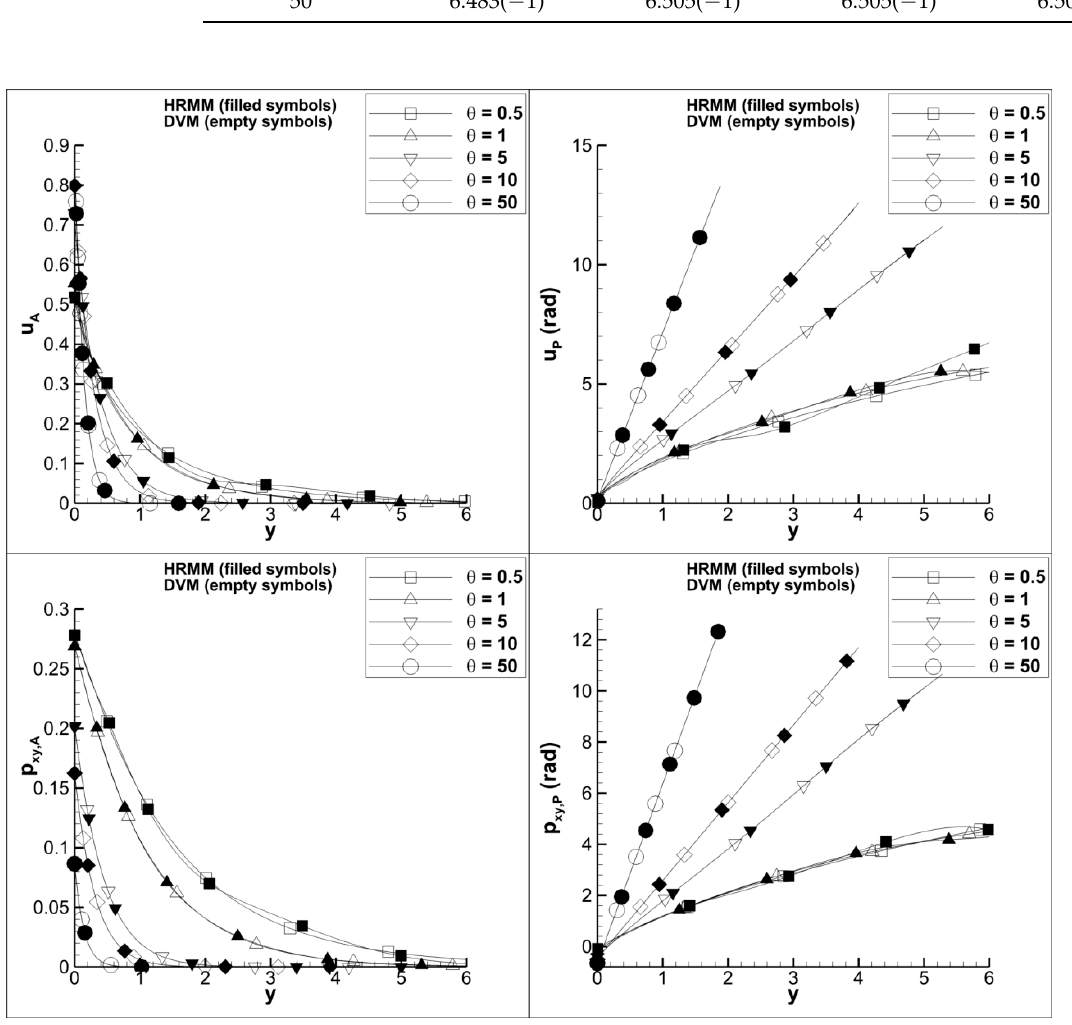
Figure 1. Oscillatory Stokes flow. Comparison between the distributions of velocity and shear stress amplitudes ( left ) and phases ( right ) obtained by the half-range moment method (HRMM) ( N = 5) and the discrete velocity method (DVM) for various values of the oscillation parameter.